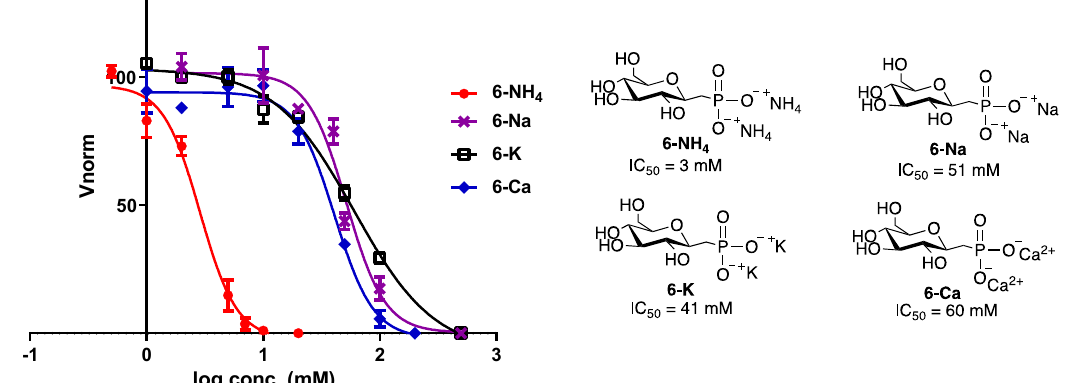
Figure 4. Structures and IRI activity of ammonium, sodium, potassium, and calcium phosphonate derivatives of 6 . IRI activity is defined by dose response curves of the rate of ice recrystallization inhibition as a function of log concentration. Rates were measured in triplicate and were normalized against a phosphate-buffered saline (PBS) control. A non-linear regression curve was fitted to points to generate IC 50 values. Error bars represent % SD for n = 3 experiments. Table 2. IRI activity of ammonium phosphonate derivatives of 5 and 6 and inorganic